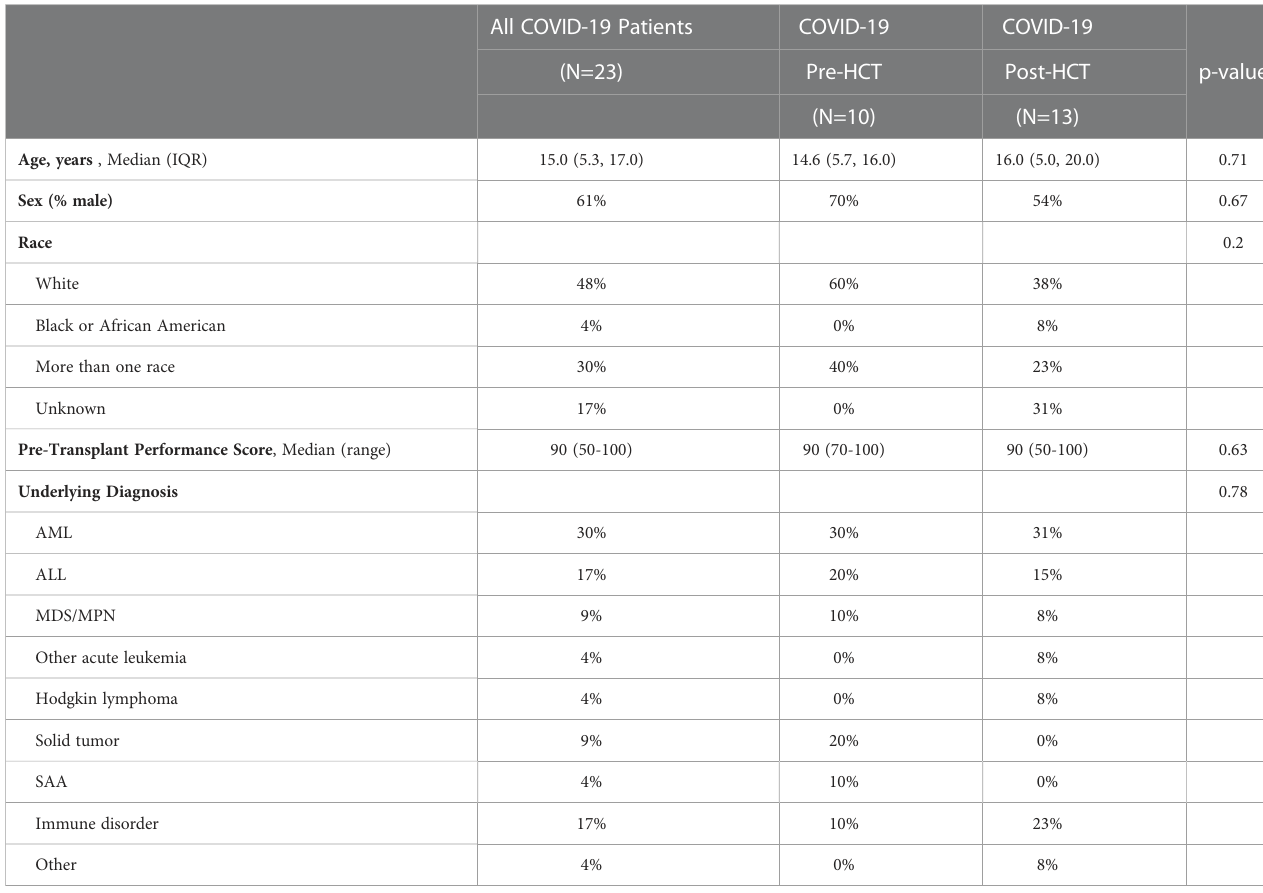
TABLE 1A Baseline demographic characteristic of HCT patients who contracted COVID-19 pre- and post-transplant.